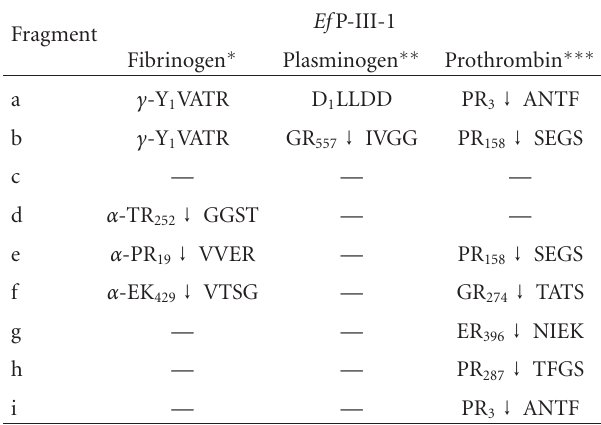
Table 1: Cleavage sites on fibrinogen, plasminogen, and prothrom- bin by Ef